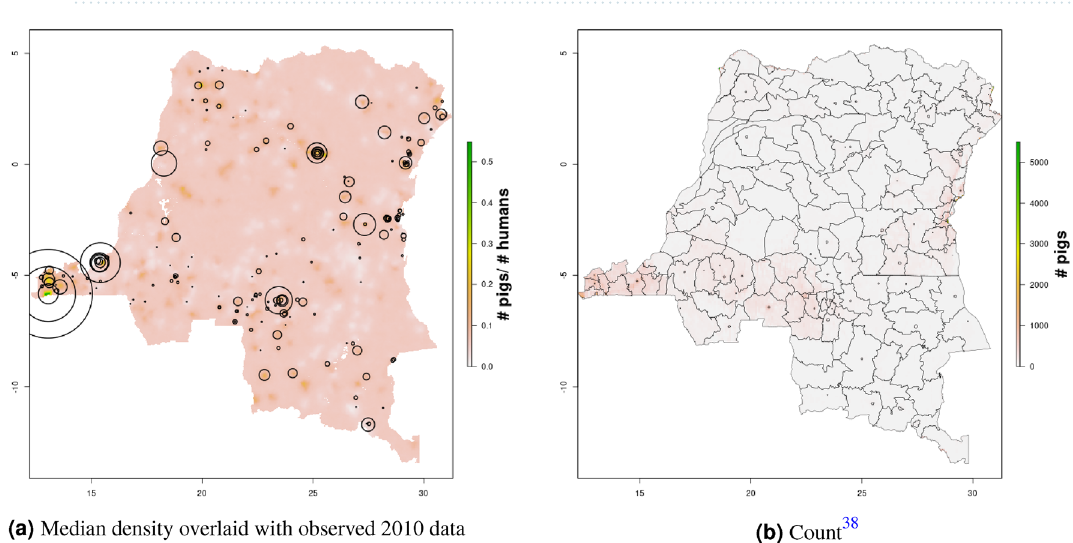
Figure 14. Median cattle density (L) compared with estimated cattle counts produced by GLW-3 (R) for DRC, both 2010.Observed density data for 2010 are presented on the left, indicated by circle size; this figure does not represent the contribution of data from other years to the model for 2010 via the temporal random effect, nor the contribution from predictors 16 .